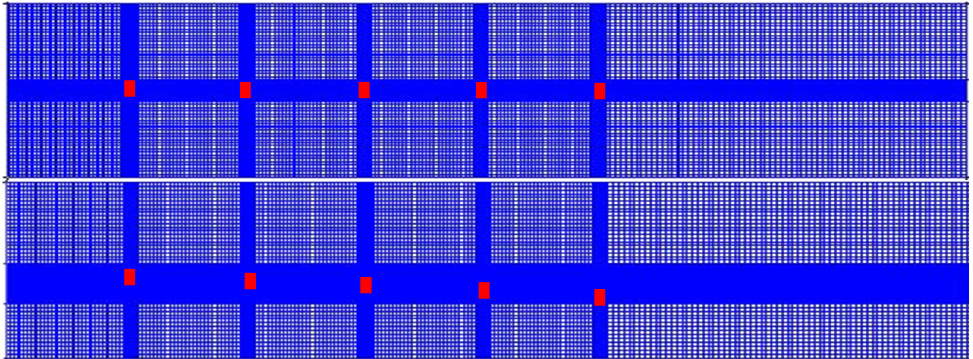
Figure 11. Grid distribution of computational domain at the ECN test onshore wind farm.